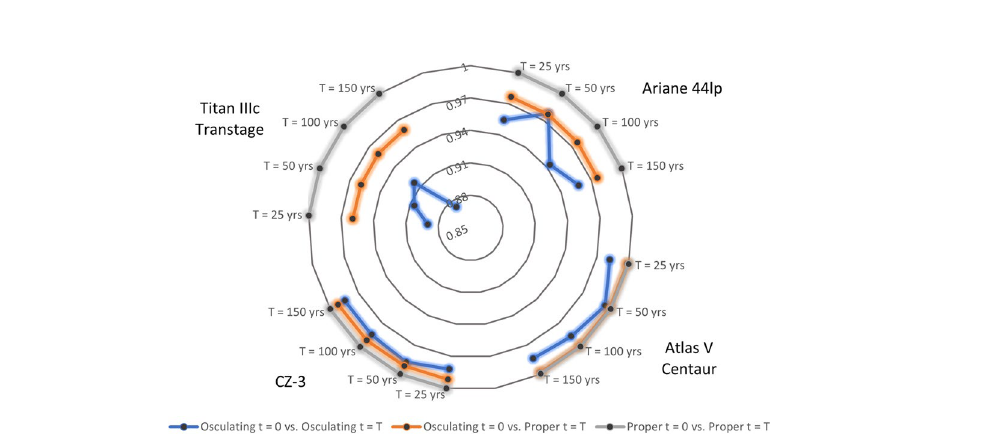
Figure 2. Comparison of the Pearson correlation coefficient for our test cases in three different combinations of the data concerning the inclination: initial osculating inclination vs final osculating inclination (blue line), initial osculating inclination vs final proper inclination (orange line), and initial proper inclination vs final proper inclination (gray line). As final times we take 25, 50, 100, 150